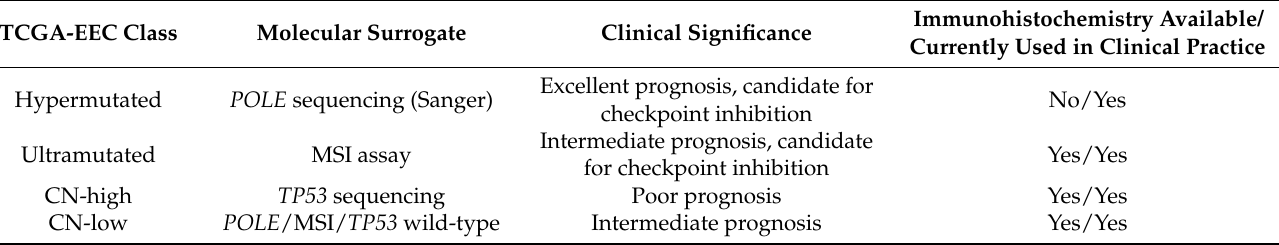
Table 3. Molecular classification of endometrioid ovarian carcinomas.